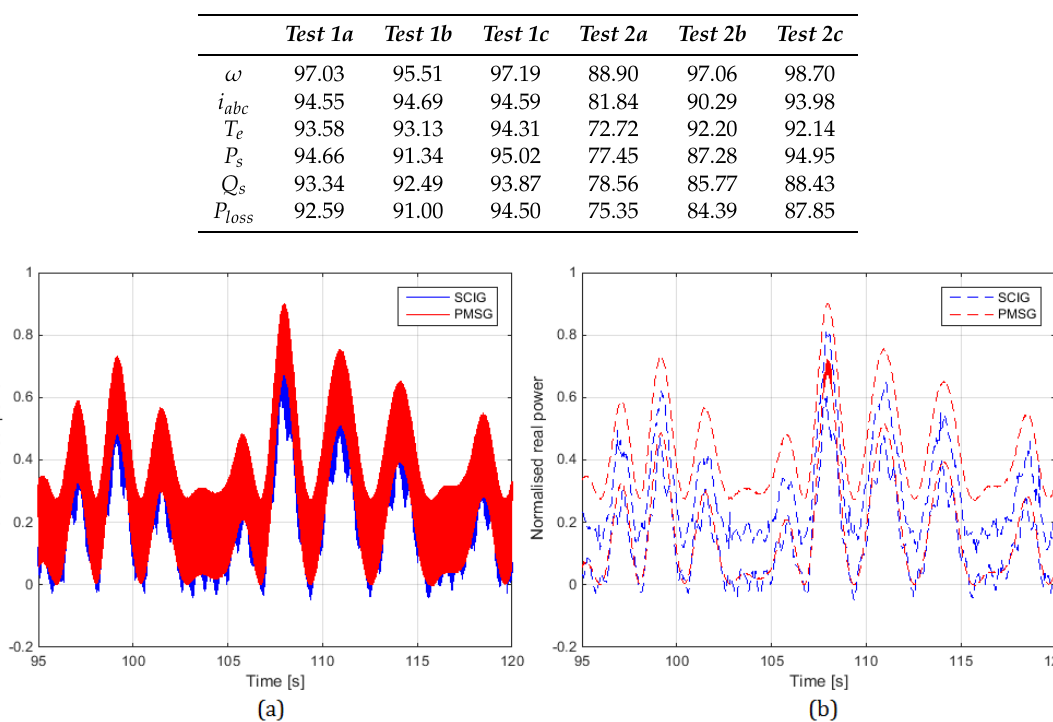
Figure 14. Real power measurements in the SCIG and the PMSG for the Test 2c test case: power values ( a ) and normalised power showing the noise level ( b